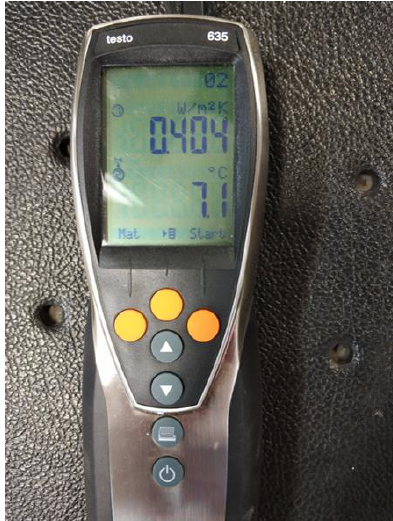
Figure 5. The U-value readings.